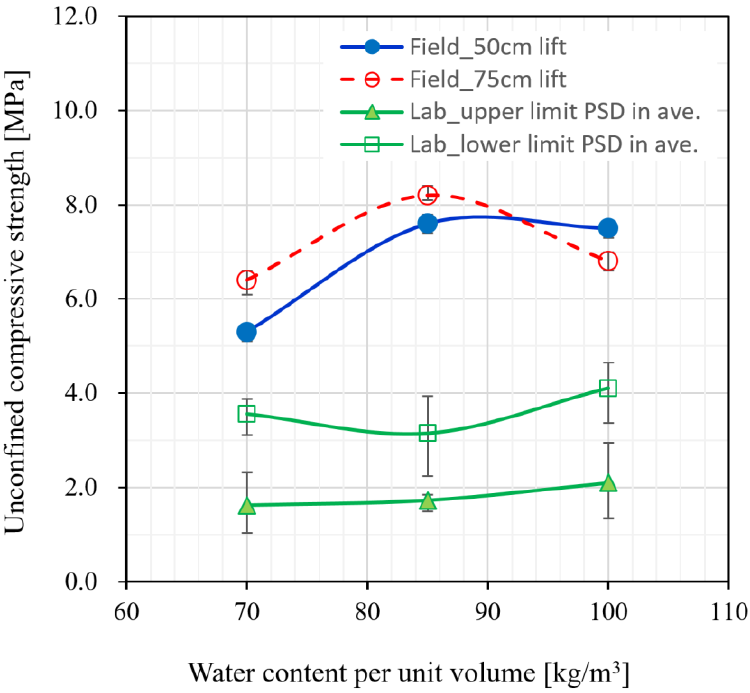
Figure 11. Uniaxial compressive strength of field-constructed hardfill (28 d of age).